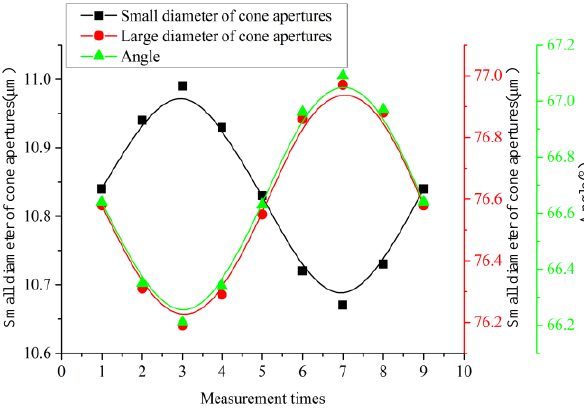
Figure 8. Variation in the parameters of the micro-tapered aperture with applied voltage. The atomization rates were measured at both the flared (forward-direction) and tapered (reverse-direction) sides under different applied voltages at 121.1 kHz, and the difference values were calculated and are plotted in Figure 9. No visible atomization was observed when the voltage was lower than 30 V; instead, drops were observed only at the micro-tapered aperture in both the forward and reverse directions. For the micro-tapered aperture operating in the forward direction, visible atomization was generated when the applied voltage was higher than 30 V, and the atomization rate increased when the applied voltage increased. For the micro-tapered aperture operating in the reverse direction, only water drops were formed even when the voltage was as high as 70 V. However, when the voltage reached 80 V, atomization began. The atomization rate measured in the forward direction was much higher than that measured in the reverse direction. This atomization rate difference increased as the applied voltage increased.